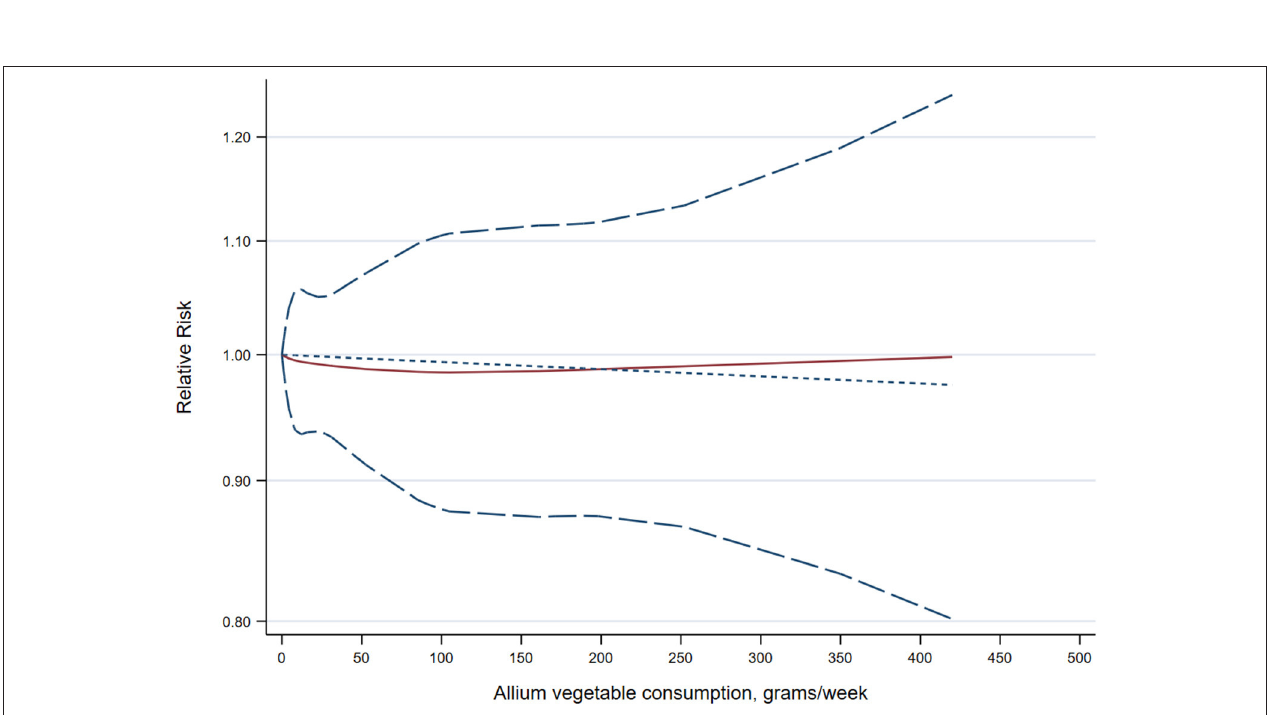
FIGURE 3 | Dose-response meta-analysis of the association between allium vegetable consumption and cancer risk. The solid line represents the linear relationship, and the short-dashed line represents the nonlinear relationship, with the long-dashed lines representing the 95% confidence intervals for the spline model.